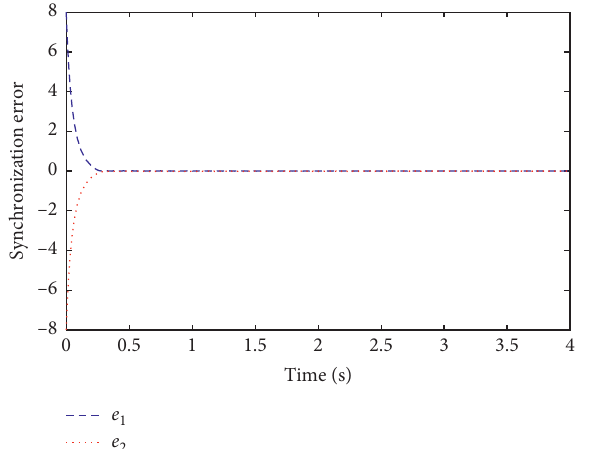
Figure 1: Predefined-time stability based on the controller (52) with time T c � 0 . 5.